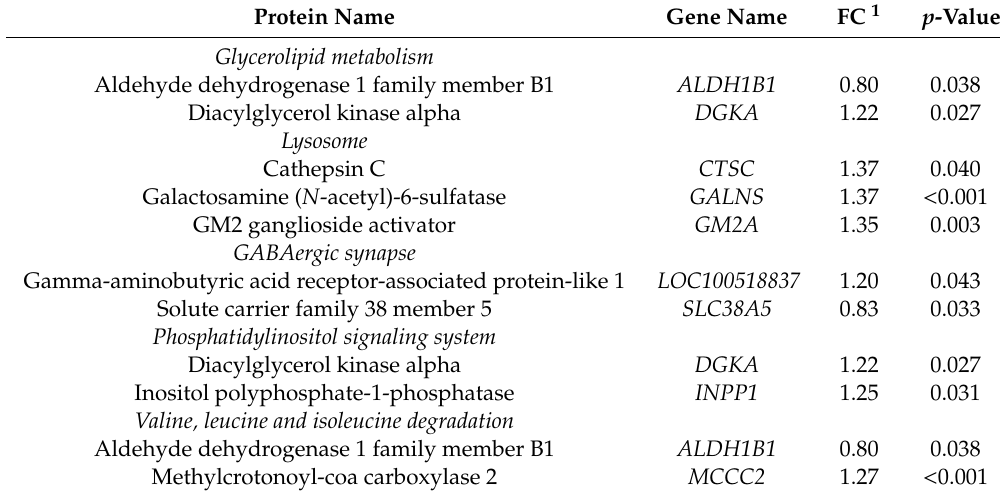
Table 2. The di ff erent expressed proteins involved in the significantly enriched KEGG